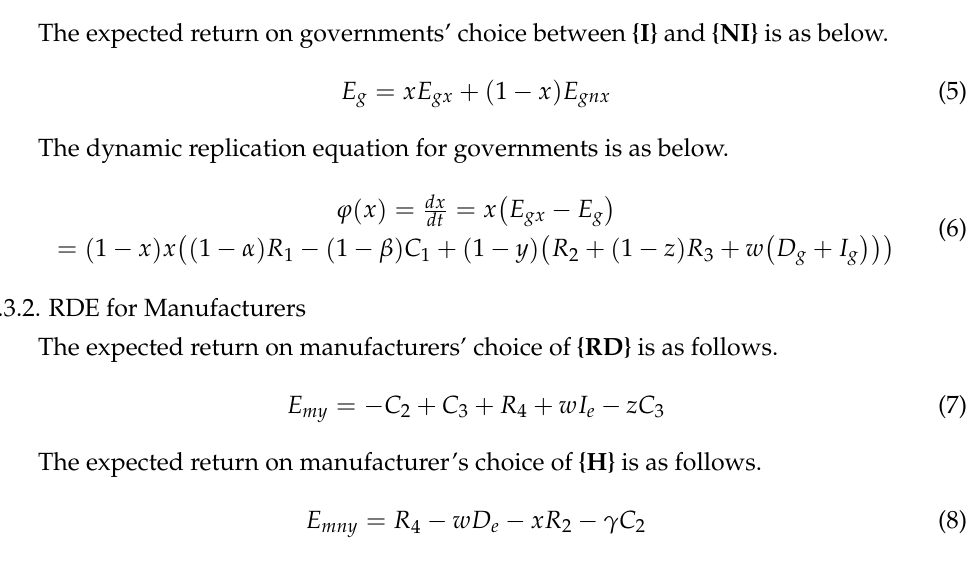
Figure 1. The dynamic game and its strategy